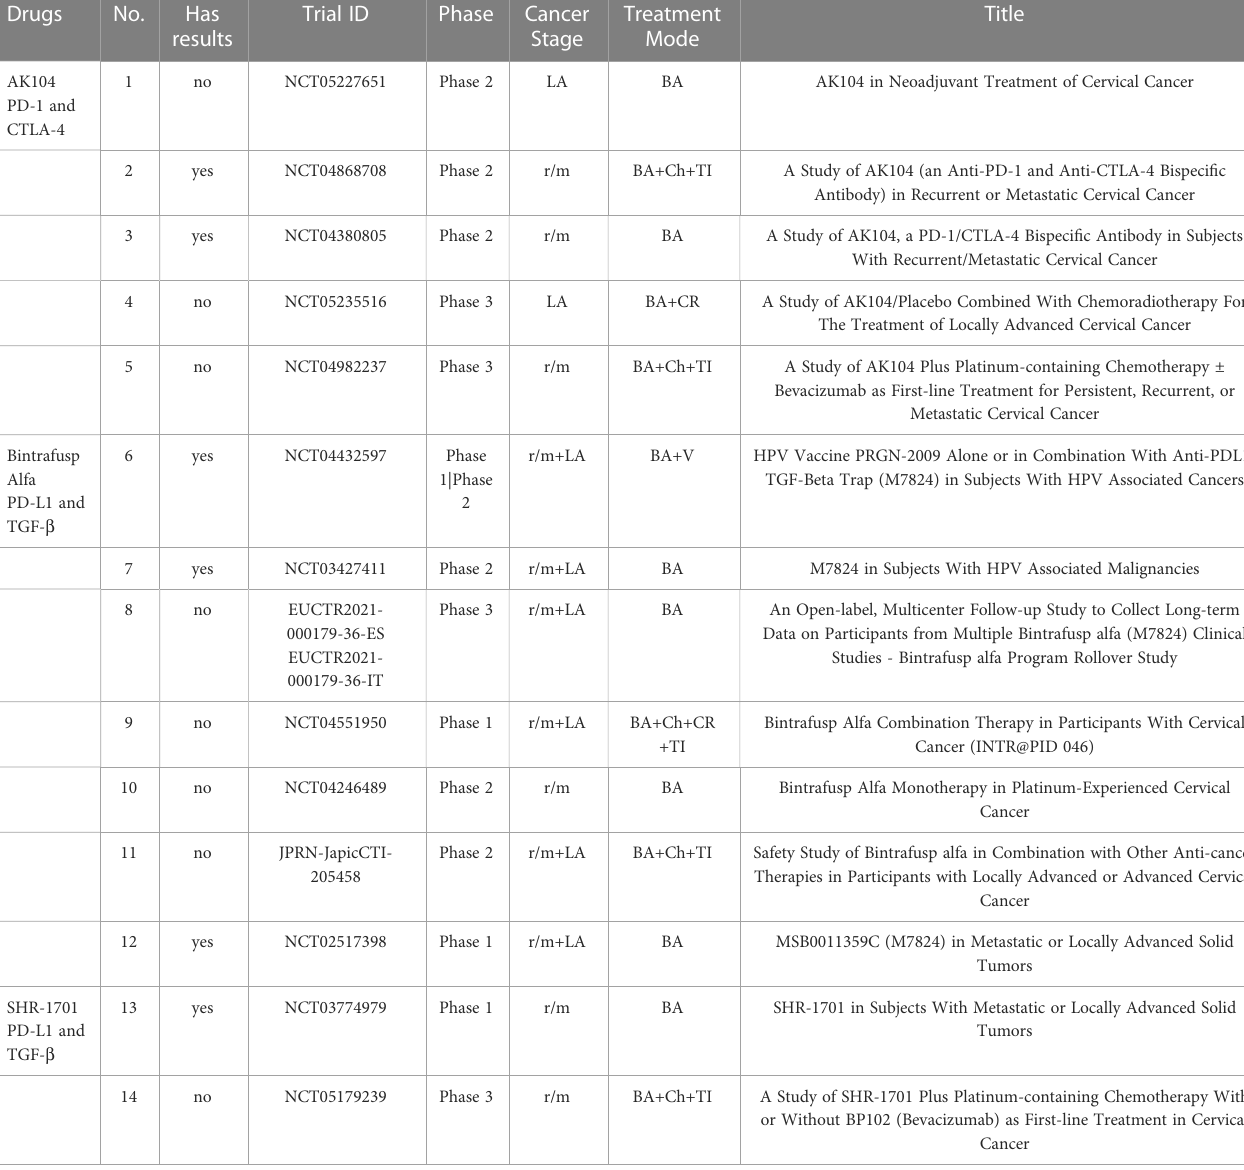
TABLE 3 The signi fi cant bispeci fi c antibodies and their correspondingly selected clinical trials. Drugs